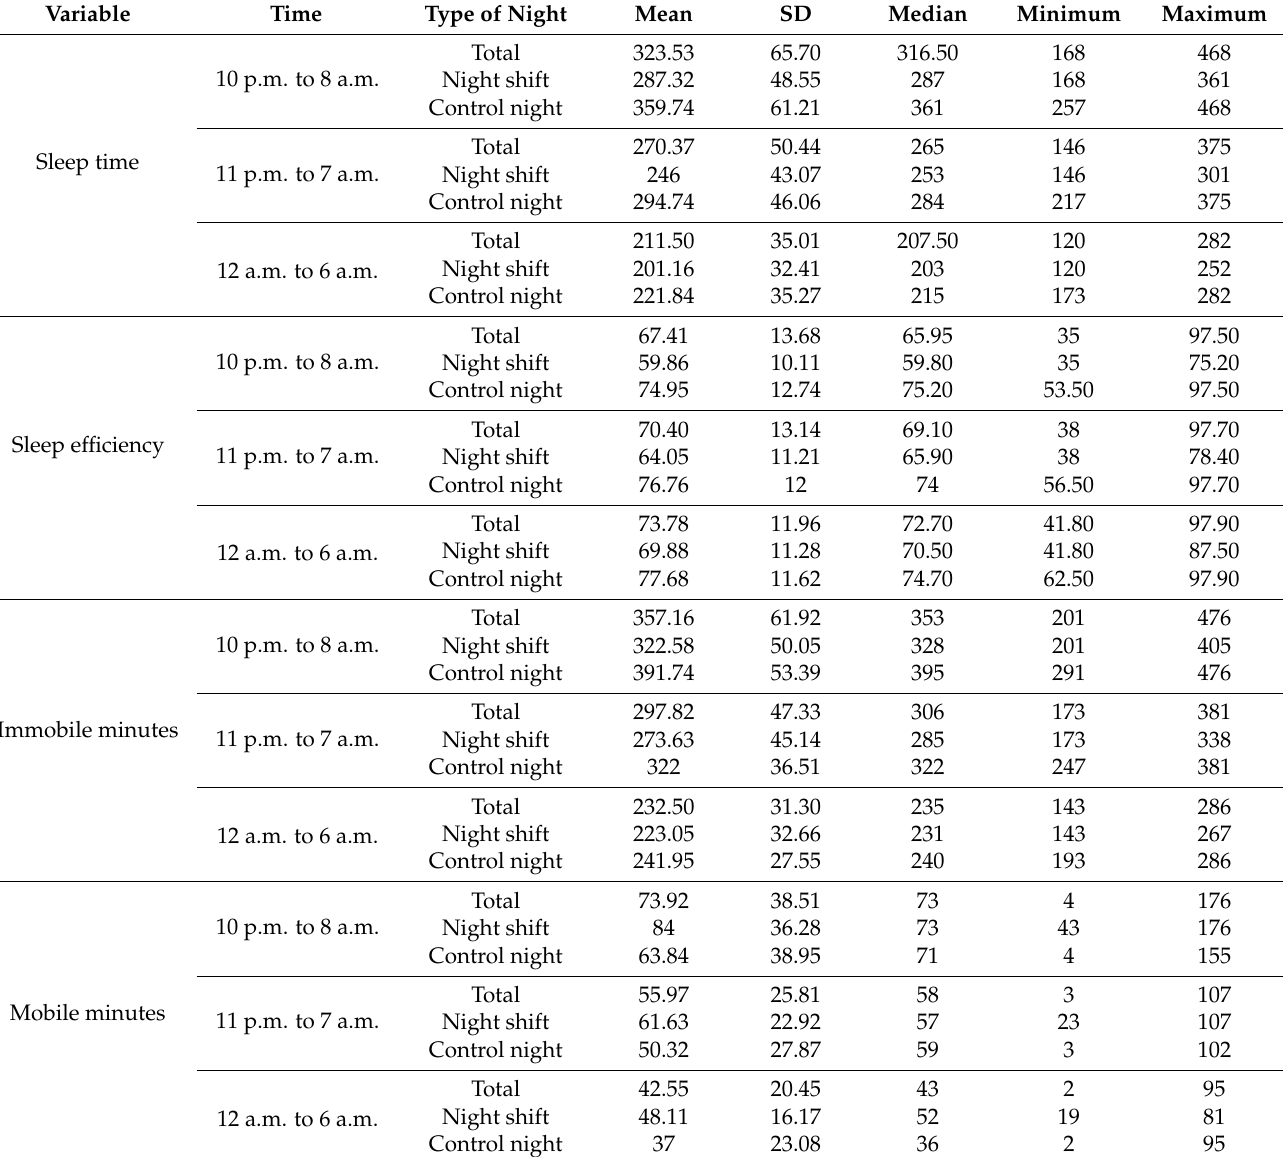
Table 2. Sleep time, sleep efficiency, mobile/immobile minutes, during the control night and the night shift (n total = 38, n night shift = 19, n control night = 19). SD, standard